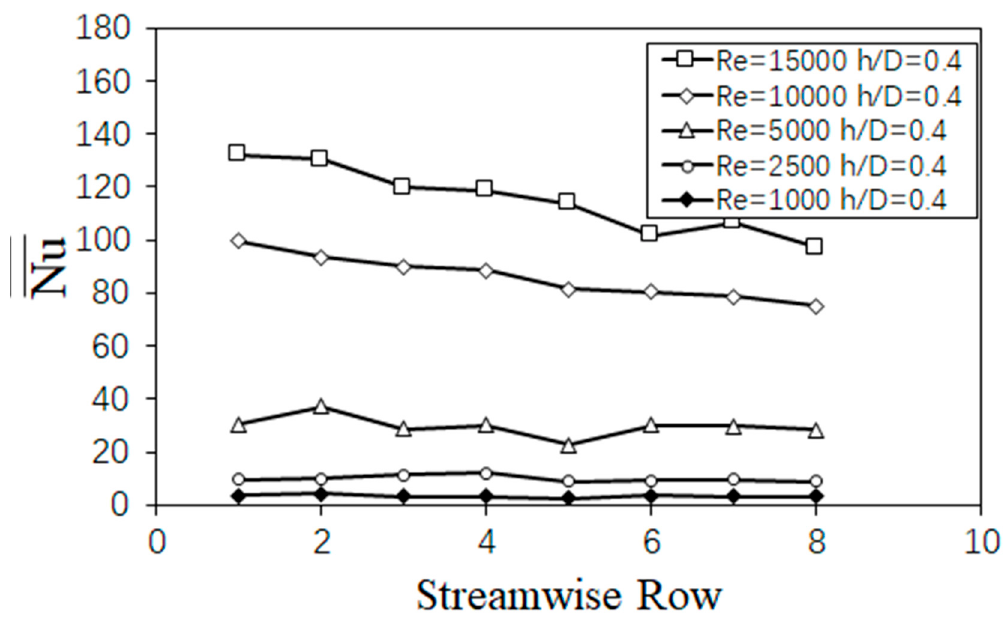
Figure 17. Spatially averaged Nusselt numbers as dependent on streamwise row location, for different Re j , for micro cooling units height of 0.4 D.